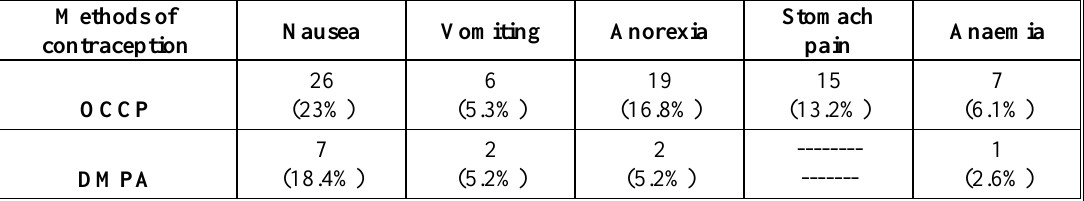
Table 5 : Number of subjects (and their percentage) used different contraceptive methods showed dermatological adverse effects Methods of